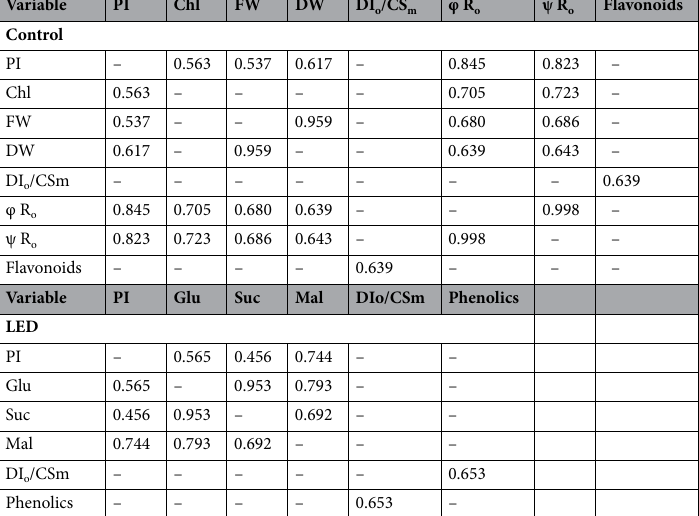
tively) (Table 5). It is worth mentioning that the ChlF related to the quantum efficiency φ Ro and ψ Ro correlated with the fresh and dry mass of the aboveground parts. The energy dissipation from PSII (DI o /CS m ) positively correlated with the content of flavonoids (r = 0.639; p < 0.05). In plants grown under LED light, PI correlated with the content of some individual sugars: glucose, sucrose, and maltose. In these plants, the DI o /CS m parameter cor- related with the total phenolic content.